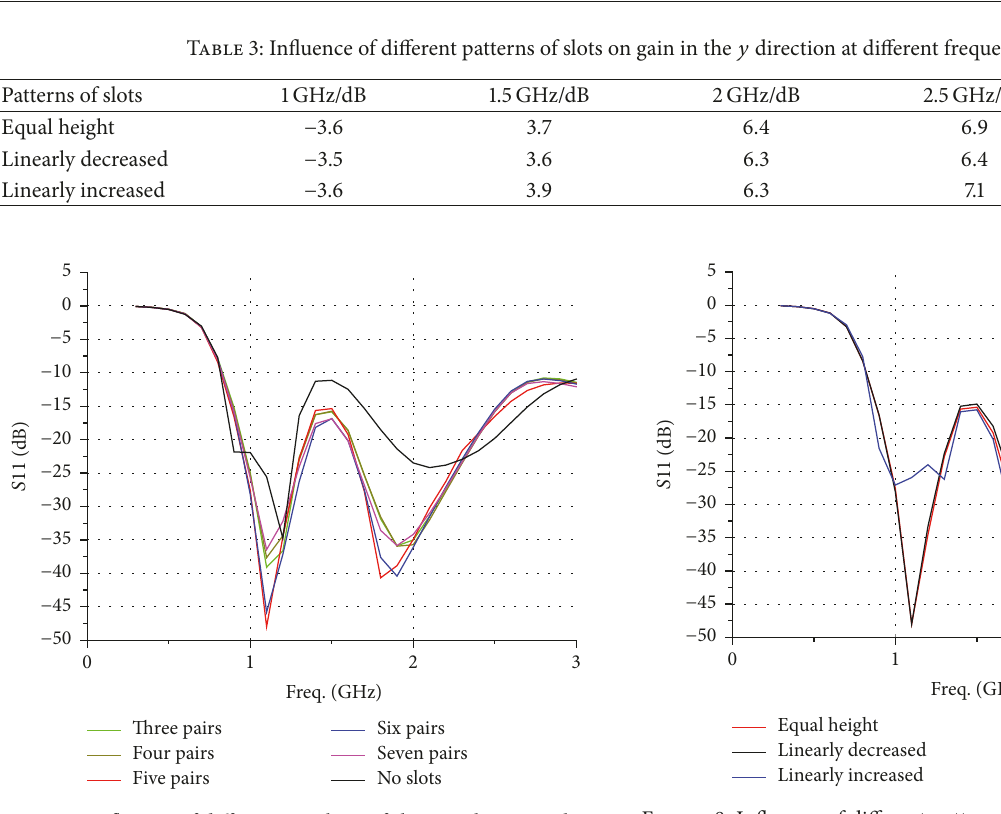
Figure 7: Influence of different numbers of slots on the return loss of the antenna.